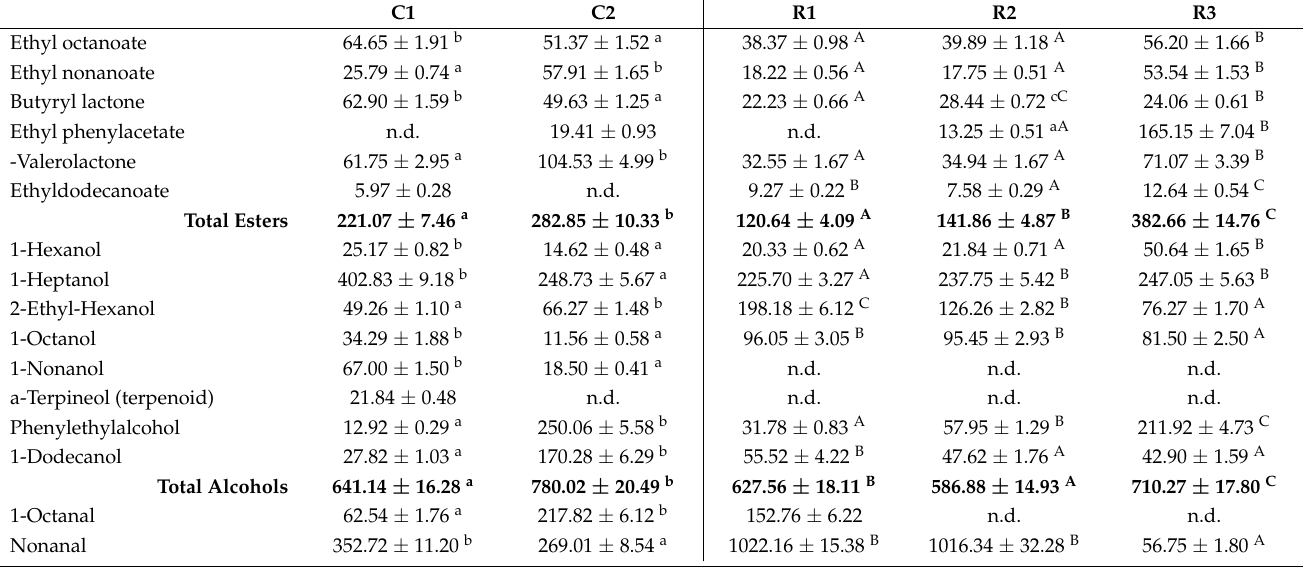
Table 4. Concentration ( µ g/L) of volatile compounds identified in colatura di alici samples. Different superscript letters between means within a row indicate statistically significant differences at p < 0.05. Lower-case letters are used for comparing C1–C2 (commercial samples); upper-case letters are used for R1–R2–R3 samples at 12-, 24-, and 48-month ripening.